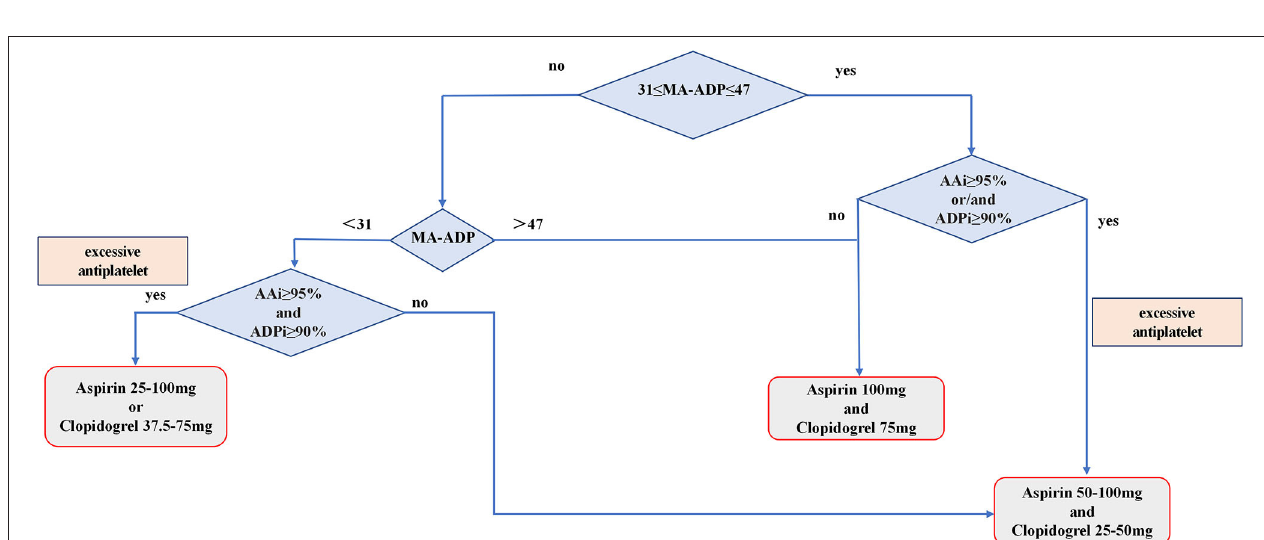
FIGURE 2 | Flowchart showing the process of patients receive individualize antiplatelet therapy based on TEG-PM parameters.